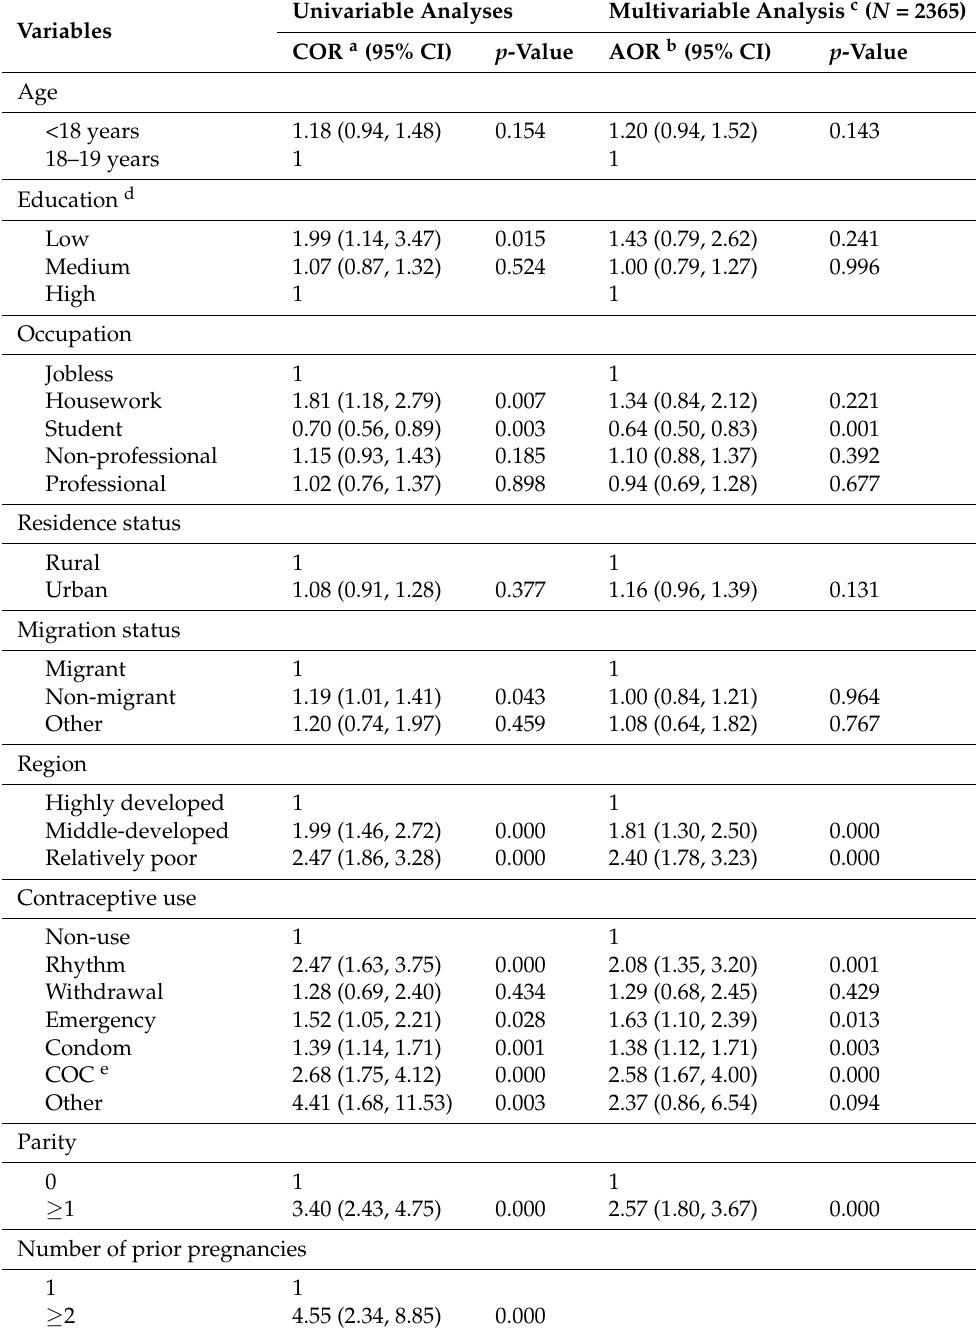
Table 3. Binary logistic regressions on risk factors related to repeat abortions of adolescents receiving